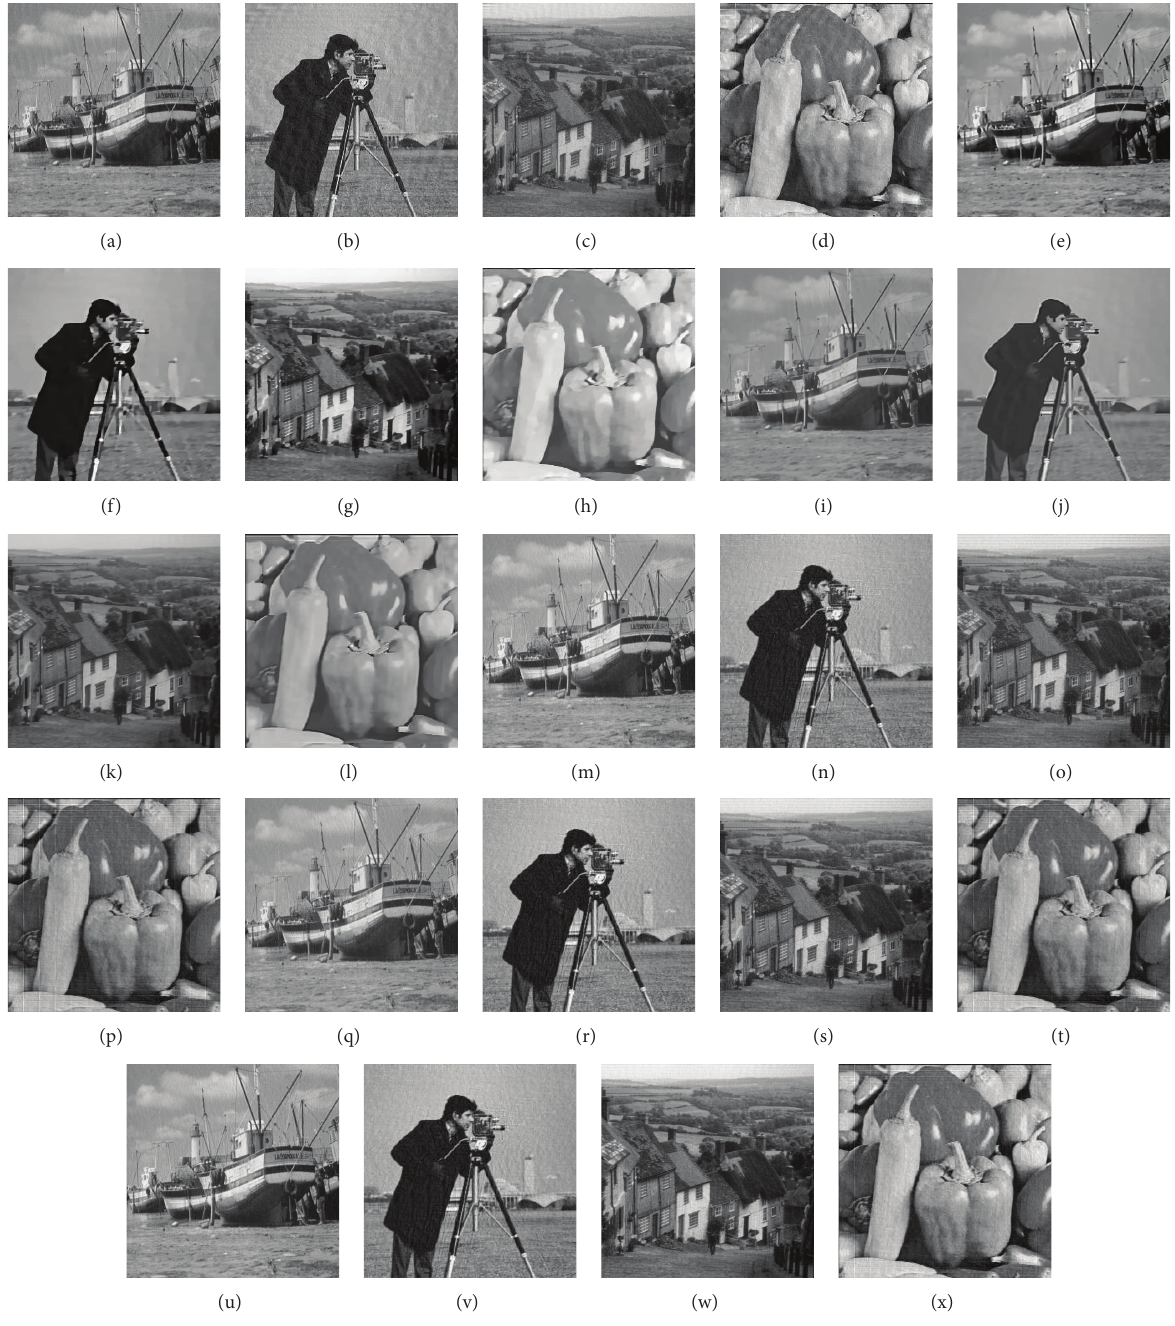
Figure 4: Restored motion blurred-noisy images obtained by ((a)–(d)) DeblurSps, ((e)–(h)) TV BOS, ((i)–(l)) NLTV BOS, ((m)–(p)) SBMTV 1/4 , ((q)–(t)) SBMTV 1/3 , and ((u)–(x)) SBMTV 4/5